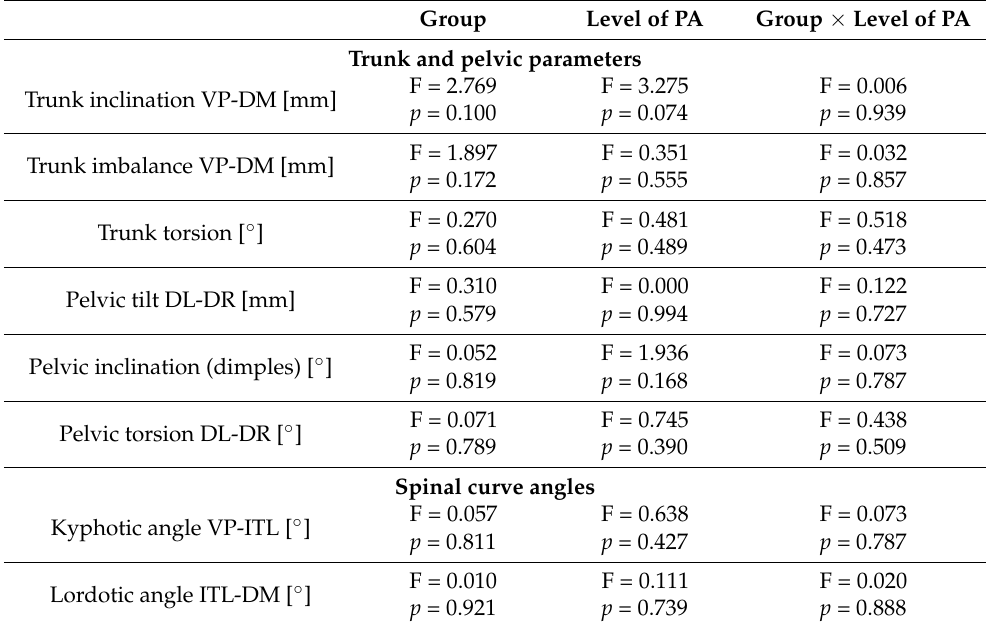
Table 6. Summary of analysis of variance for trunk alignment parameters. Group Level of PA Group × Level of PA Trunk and pelvic